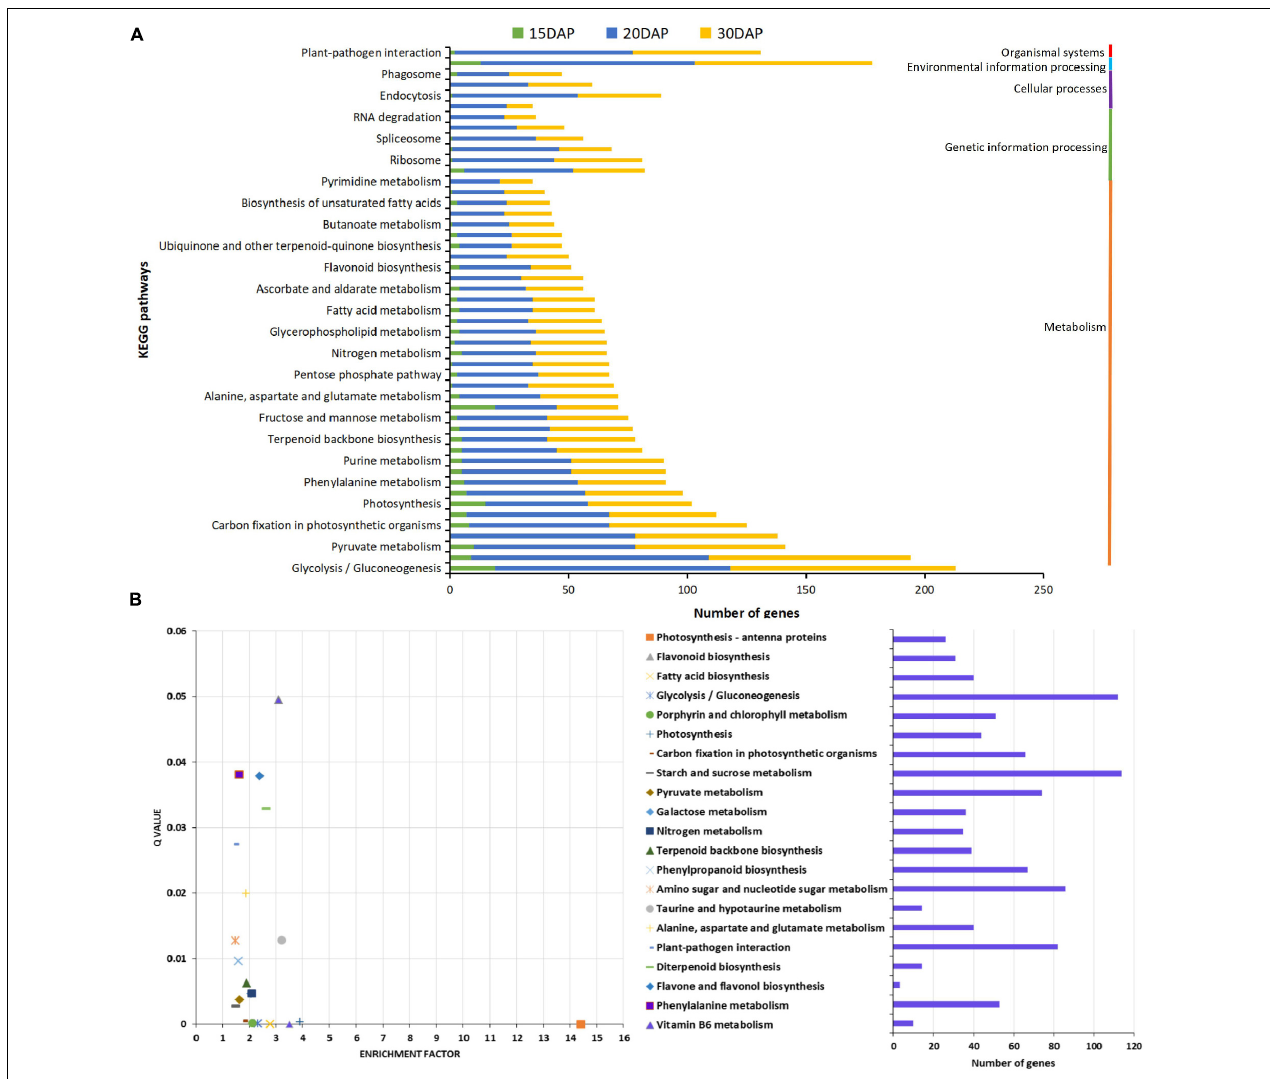
FIGURE 3 | KEGG pathways analysis for differentially expressed genes. (A) Statistical analysis of KEGG pathways for DEGs; (B) KEGG pathways enrichment analysis of